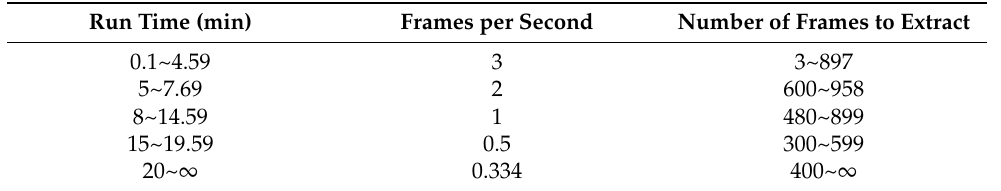
Table 1. Experimental datasets. Run Time (min) Frames per Second Number of Frames to Extract